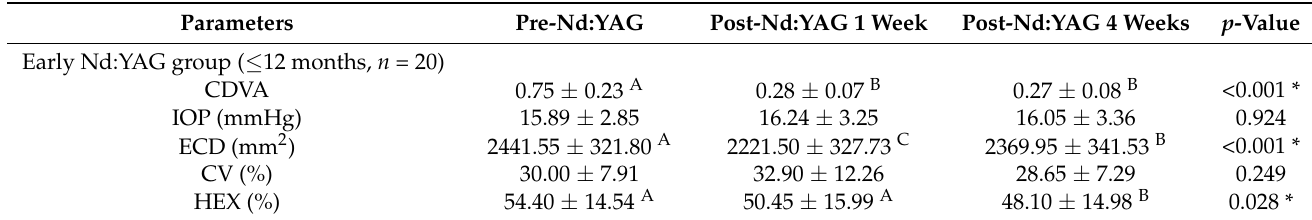
Table 2. Change of ocular and corneal parameters after early or late Nd:YAG laser capsulotomy.